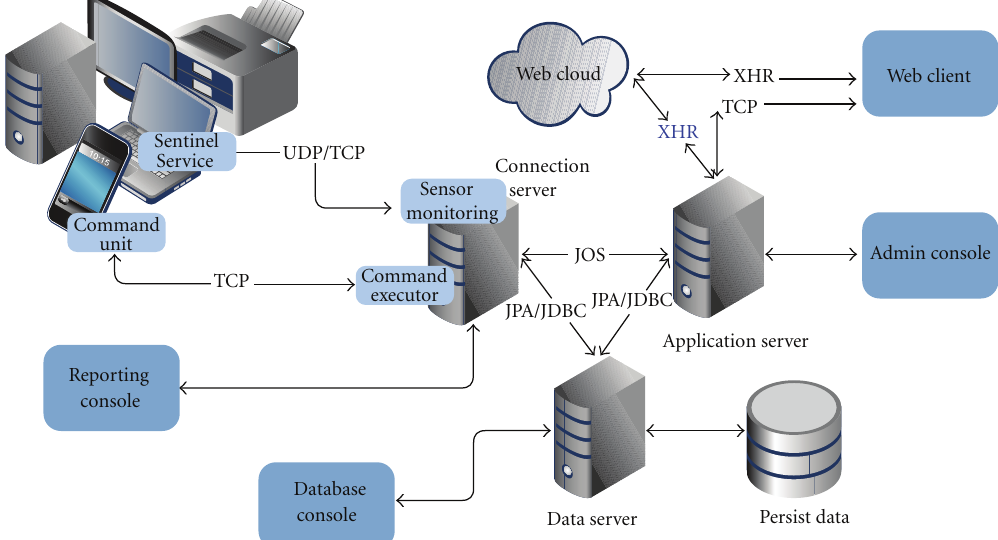
Figure 2: System architecture-Remote Device Management (using gli ff y